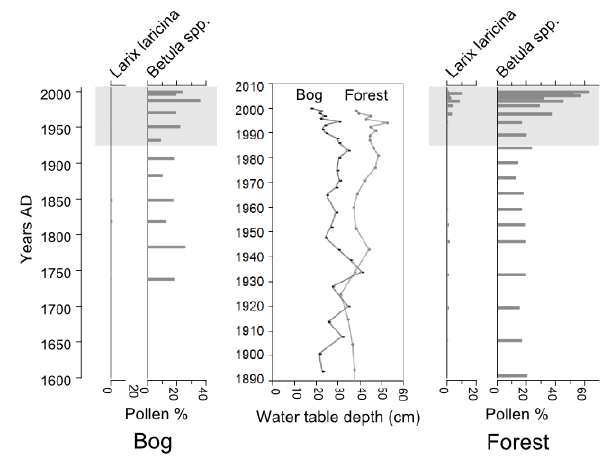
Fig. 2. Pollen records of important trees at the site and testate amoeba -based water table reconstructions from peat cores sampled on each side of the drainage ditch (approx. 60m from each ditch boundary), based on Talbot et al. (2010). The drainage ditch was es- tablished in 1922; the shaded area thus indicates the post-drainage